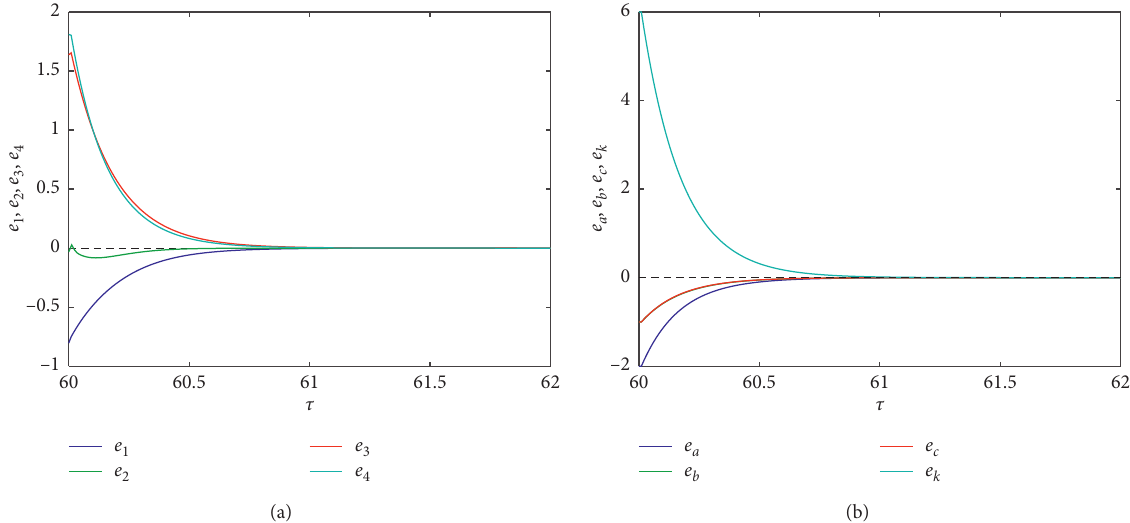
( τ ) , x ( τ ) , x ( τ ) , and x ( τ ) of master and slave systems showing the result of the adaptive law activated at τ � 1 2 3 4